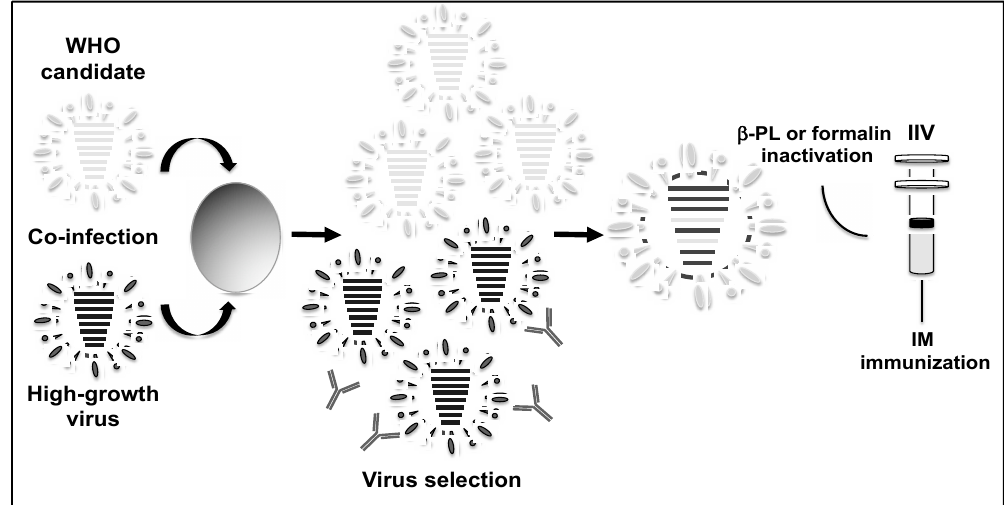
Figure 2. Production of the inactivated influenza vaccine (IIV): To prepare IIV, 10–11 days old chicken embryonated eggs are infected with two IAVs: the candidate virus recommended by the WHO (top, gray) and a high-growth virus (bottom, black). Reassortant viruses are harvested from the allantoic fluid of infected eggs 2–3 days post-infection and the appropriate reassortant virus to be included in the IIV containing the HA and NA viral segments from the WHO candidate virus (gray) and the six internal segments (PB2, PB1, PA, NP, M, and non-structural (NS)) of the high-growth virus (black) is selected by amplification in the presence of antibodies against the HA and NA glycoproteins of the high-growth virus. Genomic composition of the reassortant virus must be confirmed by sequencing. The selected virus to be used in the IIV is chemically inactivated with β -propiolactone ( β -PL) or formalin, concentrated, purified for vaccine production, and then administrated intramuscularly (IM).